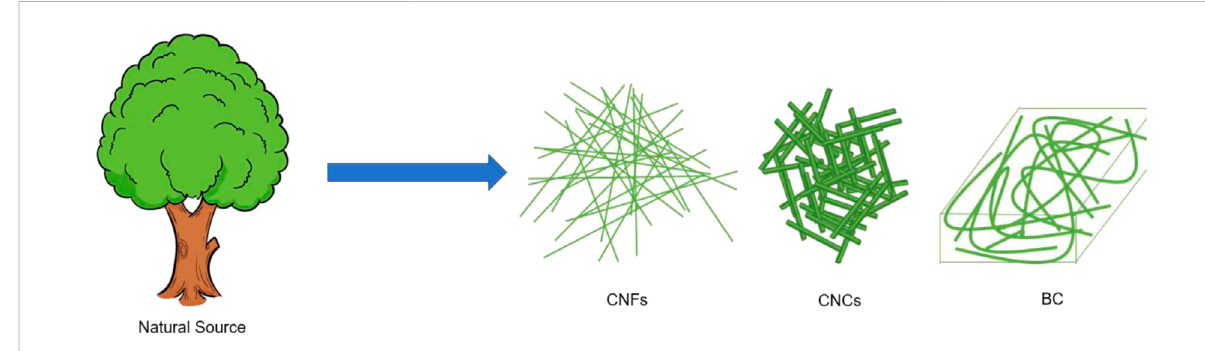
FIGURE 2 Schematic diagram of the classi fi cation of